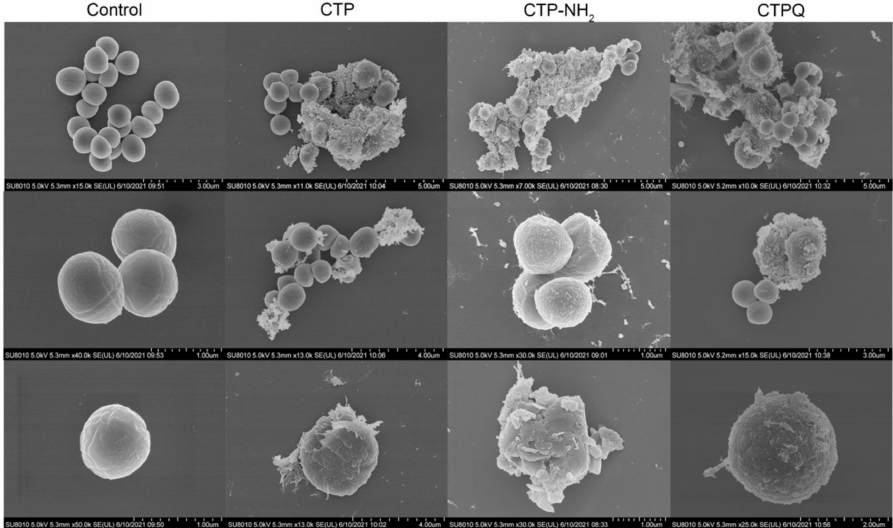
Figure 7. SEM assay of S. aureus ATCC 43300 treated with CTPs (CTP, CTP-NH 2 , and CTPQ) at the MIC (32 µ